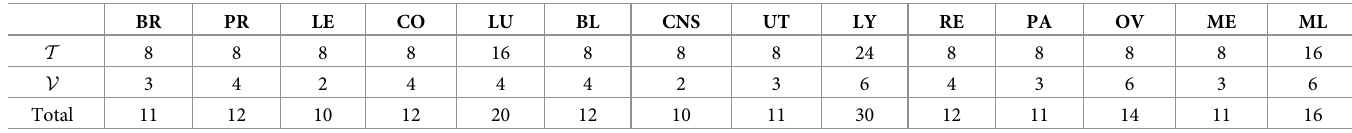
Table 1. Sample sizes for each cancer. The first row with T contains sample sizes of the training data in cancer labels; the second row with V contains sample sizes of the testing data in cancer labels; the last row with “Total” contains sample sizes of the whole data in cancer